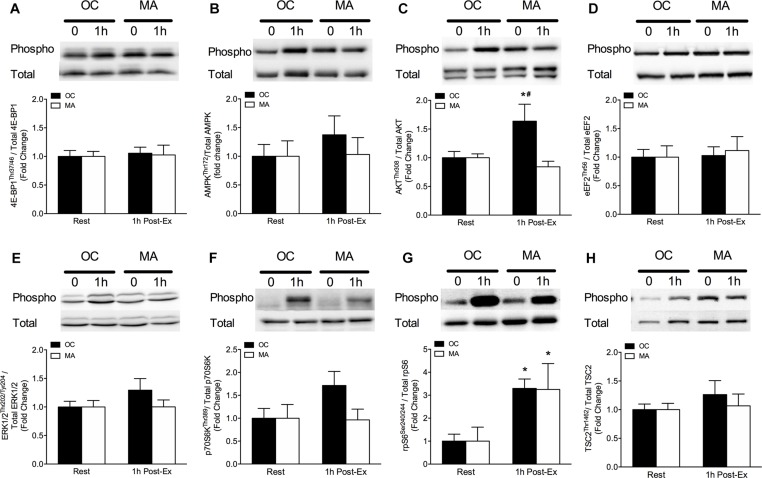
Intramuscular anabolic signaling of (A) 4E-BP1Thr37/46, (B) AMPKThr72, (C) AktThr308, (D) eEF2Thr56, (E) ERK1/2Thr202/Tyr204, (F) p70S6KThr389, (G) rpS6Ser240/244, and (H) TSC2Thr1462 at rest and 1 h post-resistance exercise in older untrained controls (OC, black bars) and Master Athletes (MA, white bars). All proteins are expressed relative to their respective total protein abundance. Significance was set at P < 0.05. The symbol “∗” indicates significantly different from rest (P < 0.05). The symbol “#” indicates significantly different from MA (P < 0.05). Values are presented as means ± SEM.